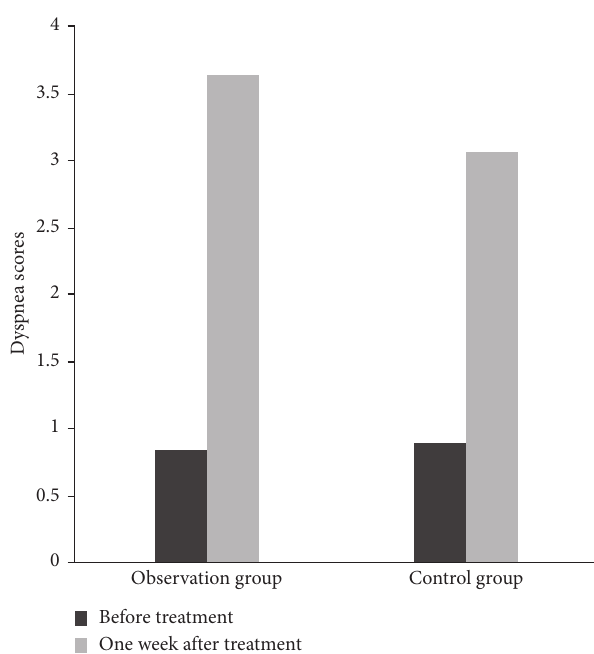
Figure 4: Comparison of dyspnea scores between the two groups. Note: compared with the same group before treatment ( a P < 0 . 05) and the control group after treatment ( b P < 0 . 05).